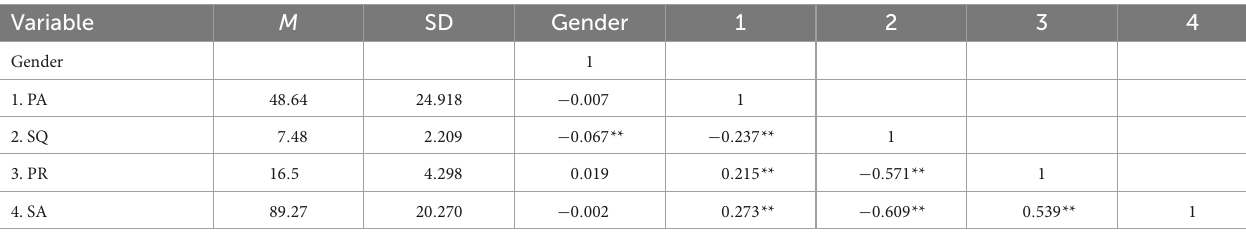
TABLE 1 Means, standard deviations, and correlations among variables.